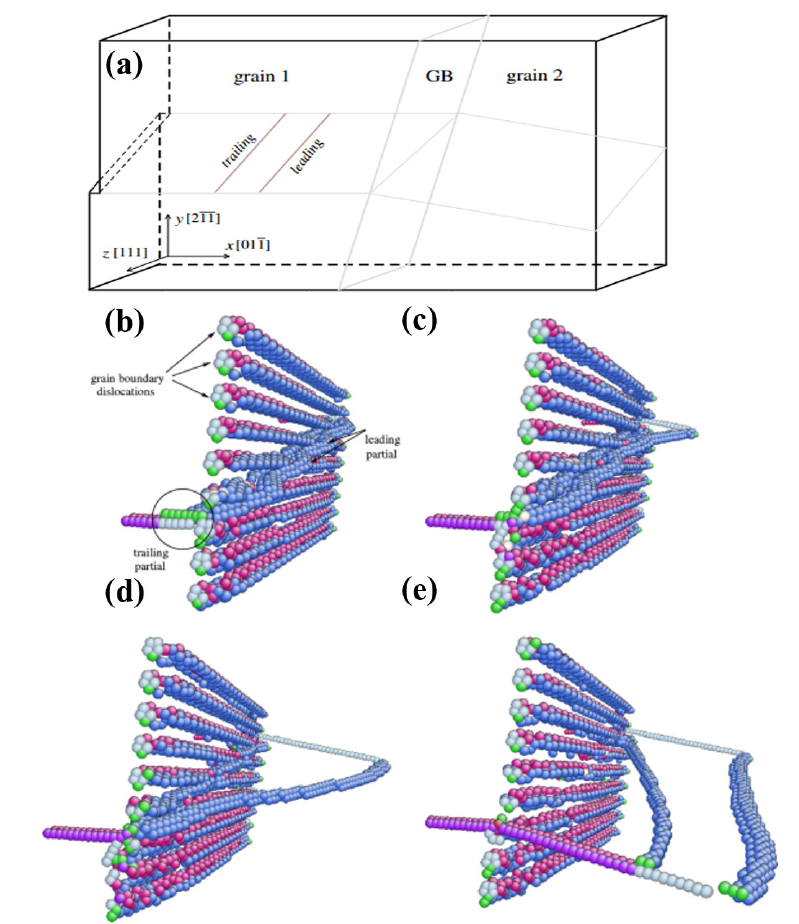
Figure 2. ( a ) Simulation box containing two grains misoriented around the [111] rotation axis for simulating the interaction between a lattice dislocation and a tilt GB. ( b – e ) Snapshots showing different steps of the interaction between a dislocation and a symmetrical Σ 57 tilt GB. Figure taken from Ref. [33] with